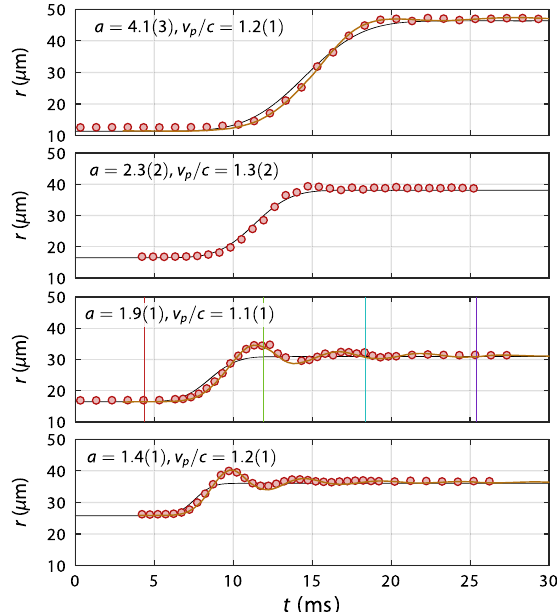
FIG. 3. Mean radius of the ring vs time for select expansions. Black solid curves show the radius of the potential, red circles show experimental data, and orange curves show simulation results. The vertical lines for a ¼ 1 . 9 ð 1 Þ correspond to times shown in Fig.